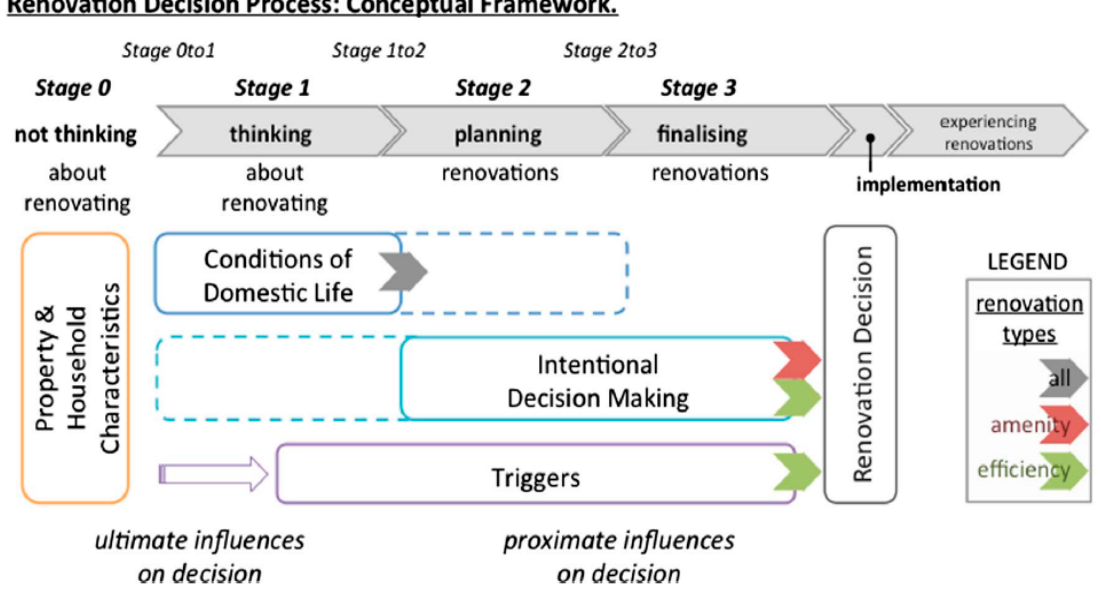
Figure 1. Conceptual framework for renovation decision made in the context of everyday domestic life (retrieved from [47]).